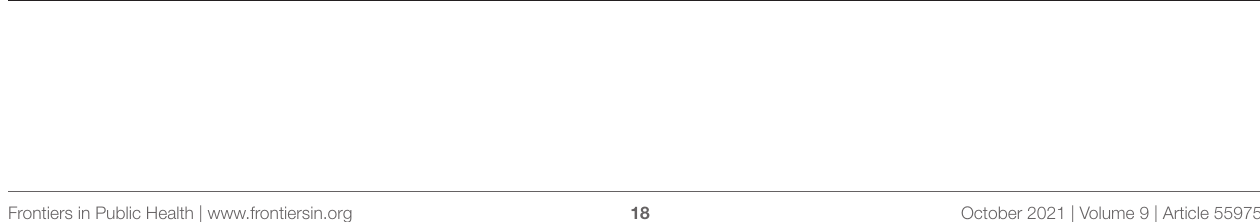
Frontiers in Public Health |